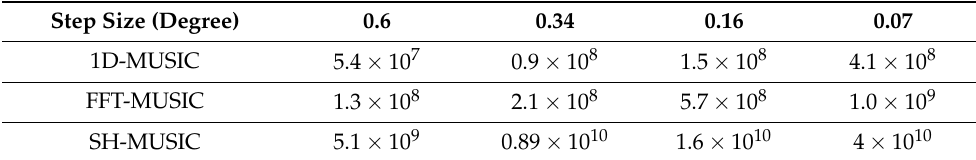
Table 3. Multiplication Operational Complexity.